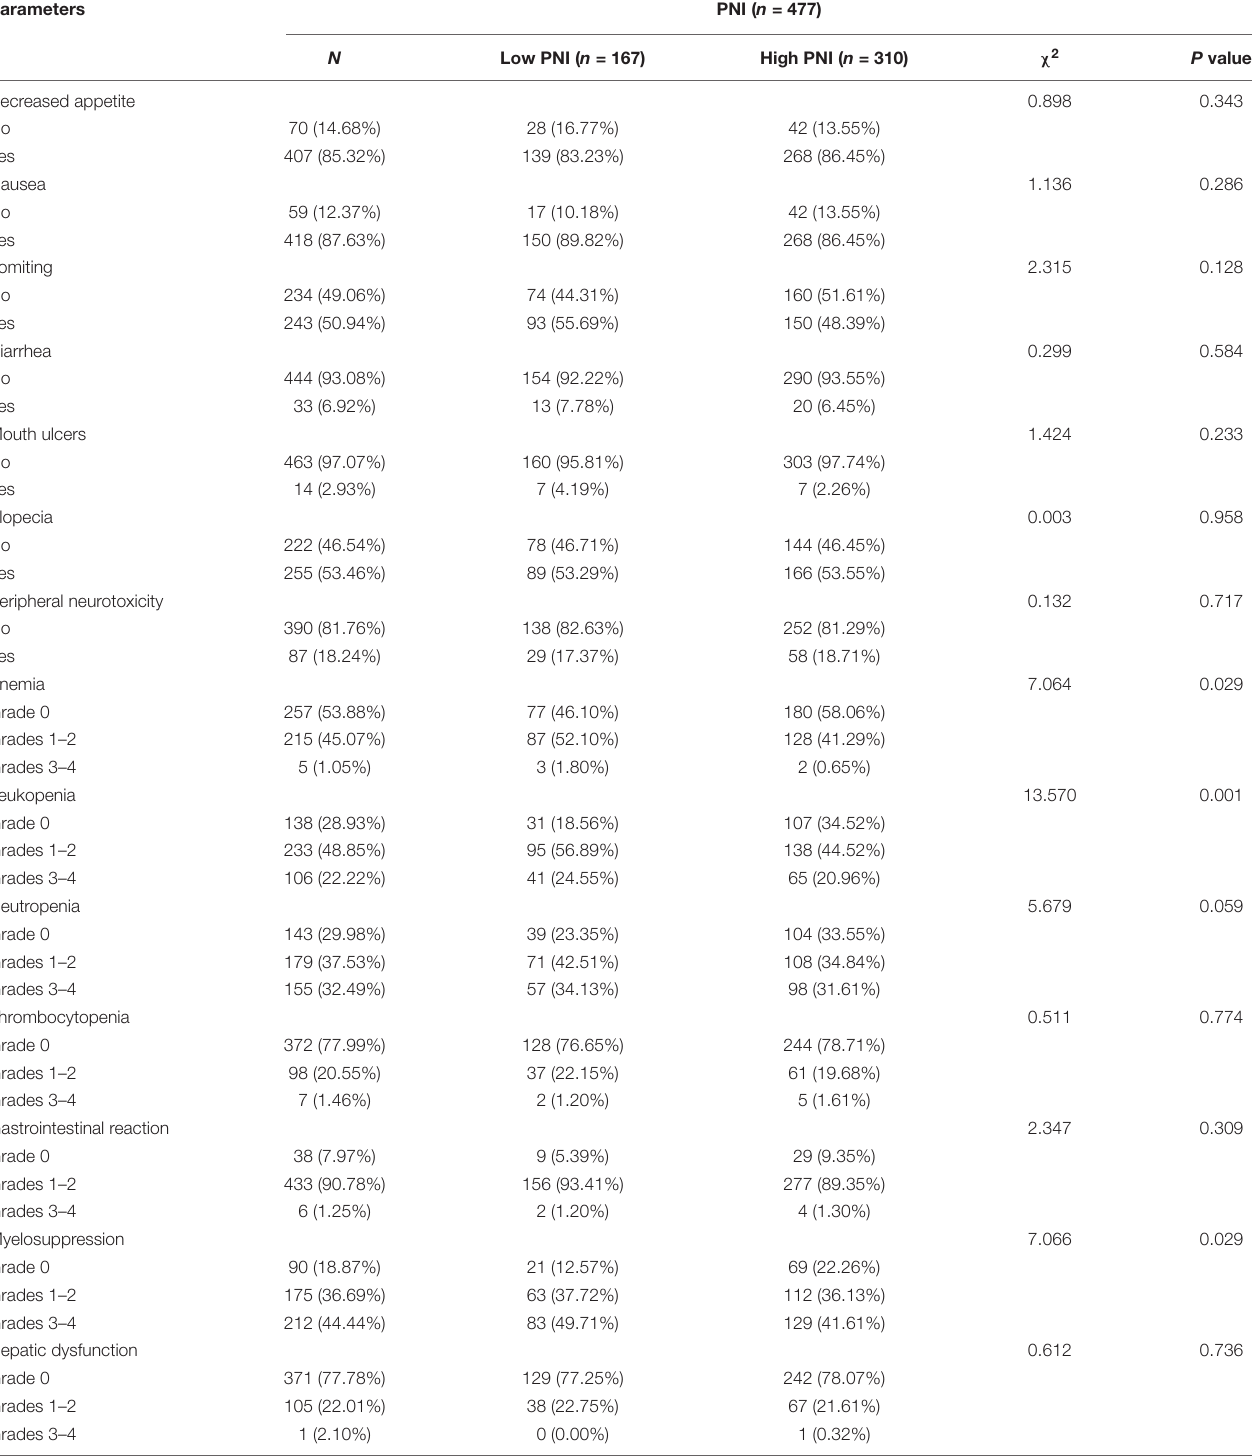
TABLE 2 | Correlations between PNI and toxicity